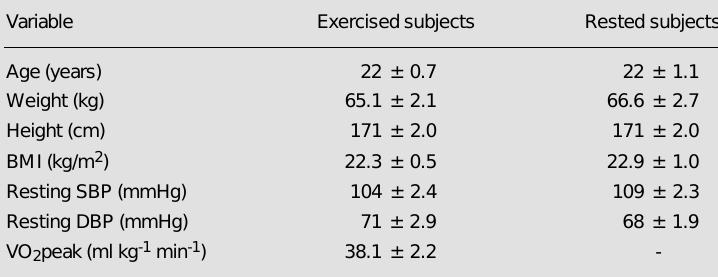
Table 1 - Physical and cardiovascular characteristics of the subjects